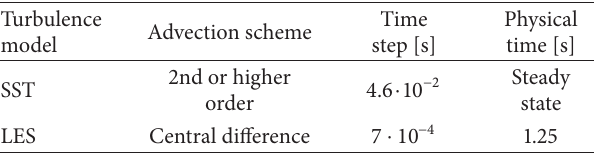
Table 2: Convergence criteria and advection